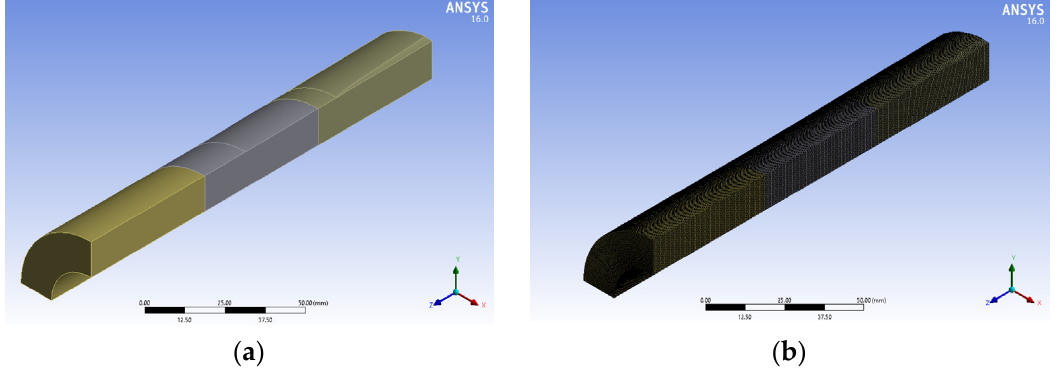
Figure 10. Geometry ( a ) and mesh ( b ) for the under-investigation heat transfer problem.